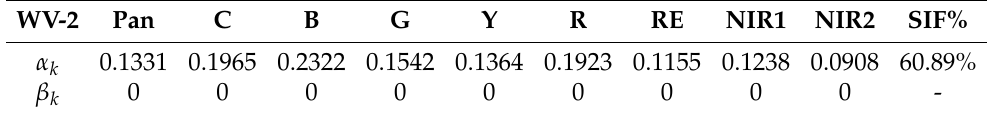
Table 2. Gains and offsets for conversion to SR of